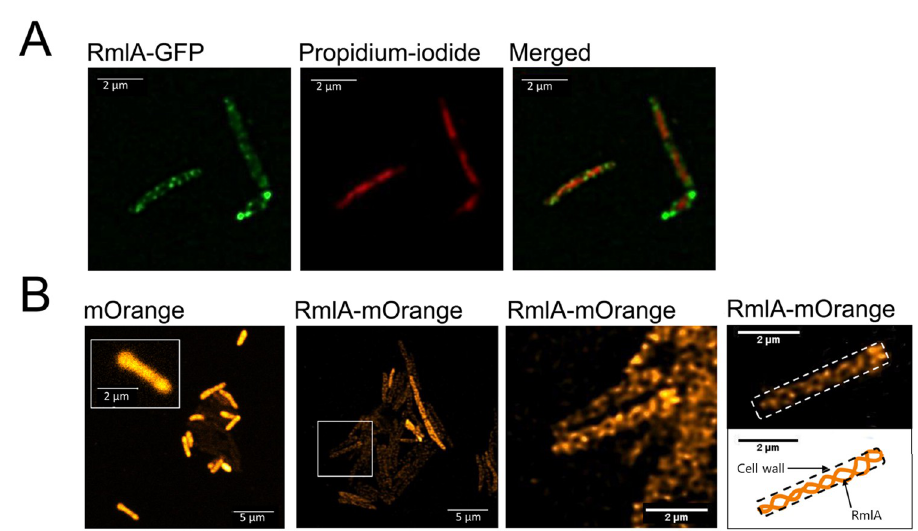
Fig 9. The cellular localization pattern of fluorescently tagged RmlA. To investigate the cellular localization of RmlA, we constructed M . smegmatis strains expressing GFP (A) and mOrange-2 (B) tagged RmlA under the control of the endogenous RmlA promoter. A) The localization pattern of the GFP tagged protein was observed using confocal microscopy. Of the 57 cells analyzed, all exhibited a helical fluorescence pattern here. DNA was stained with propidium iodide. B) The localization of mOrange-2 tagged protein was investigated using STED super-resolution imaging. We found that in all 68 cells analyzed, RmlA localized to the cell perimeter in a helix-like pattern, while no helicity was observed in the mOrange controls (mOrange panel in Fig 9B). Cell boundaries are indicated with a dashed